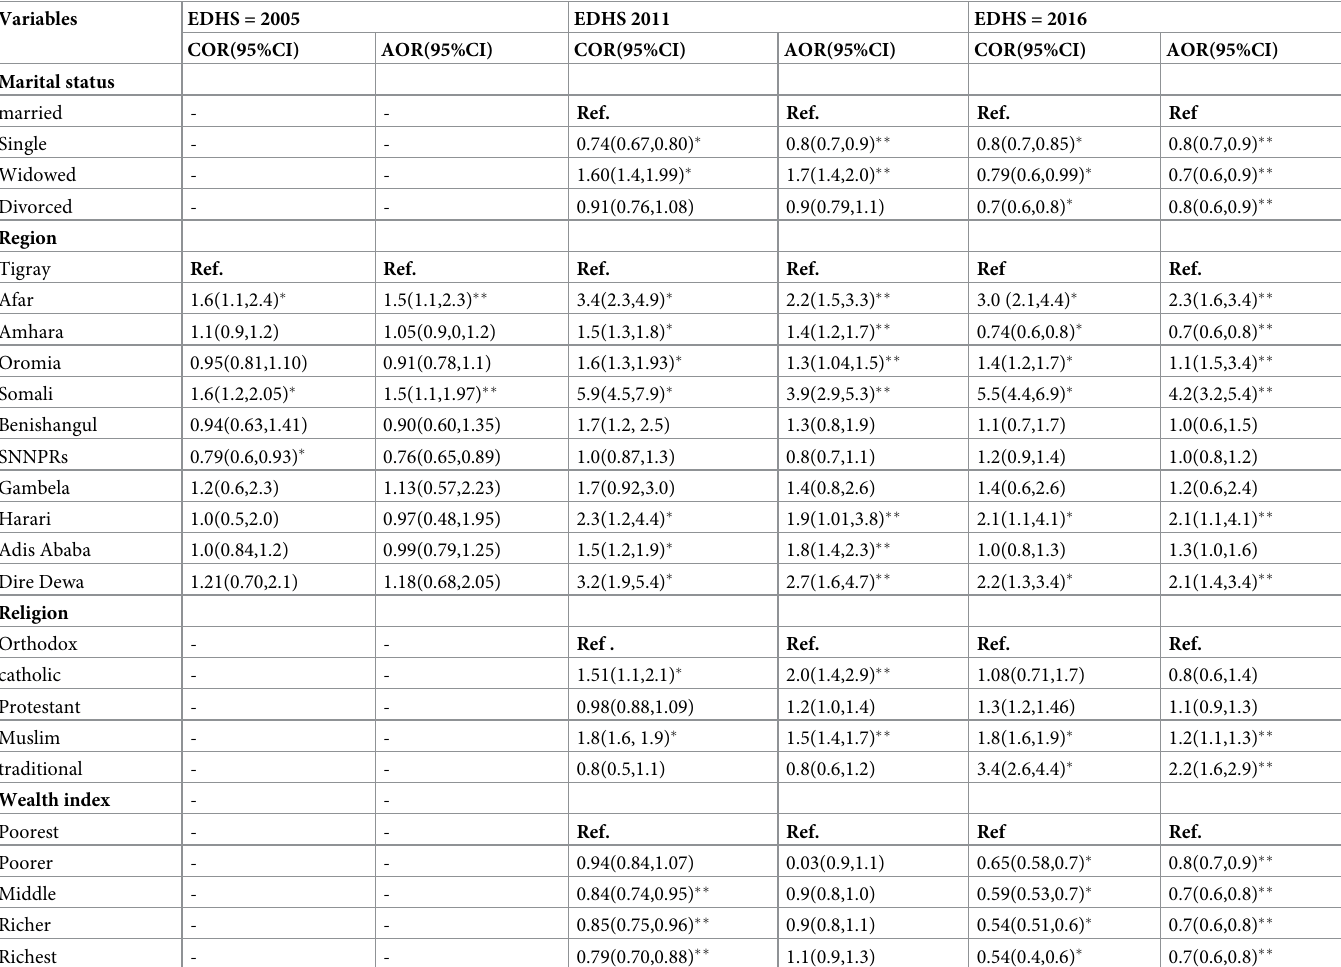
Table 5. Socio-demographic predictors of anemia among study participants (N =